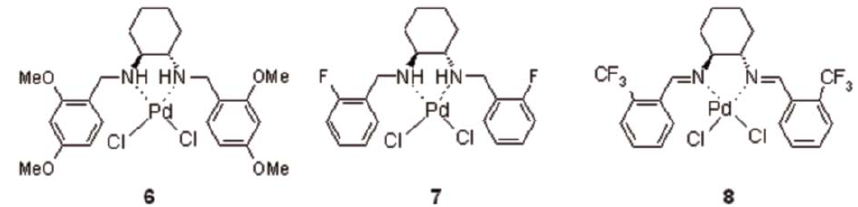
Figure 2. Structure of Pd-diamine and Pd-diimine